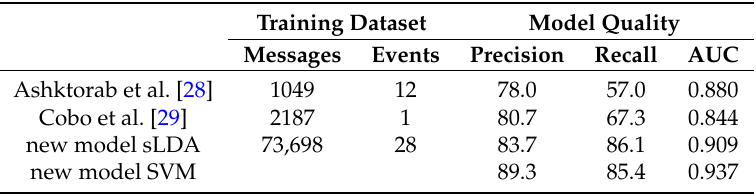
Table 3. Model quality compared to the baseline